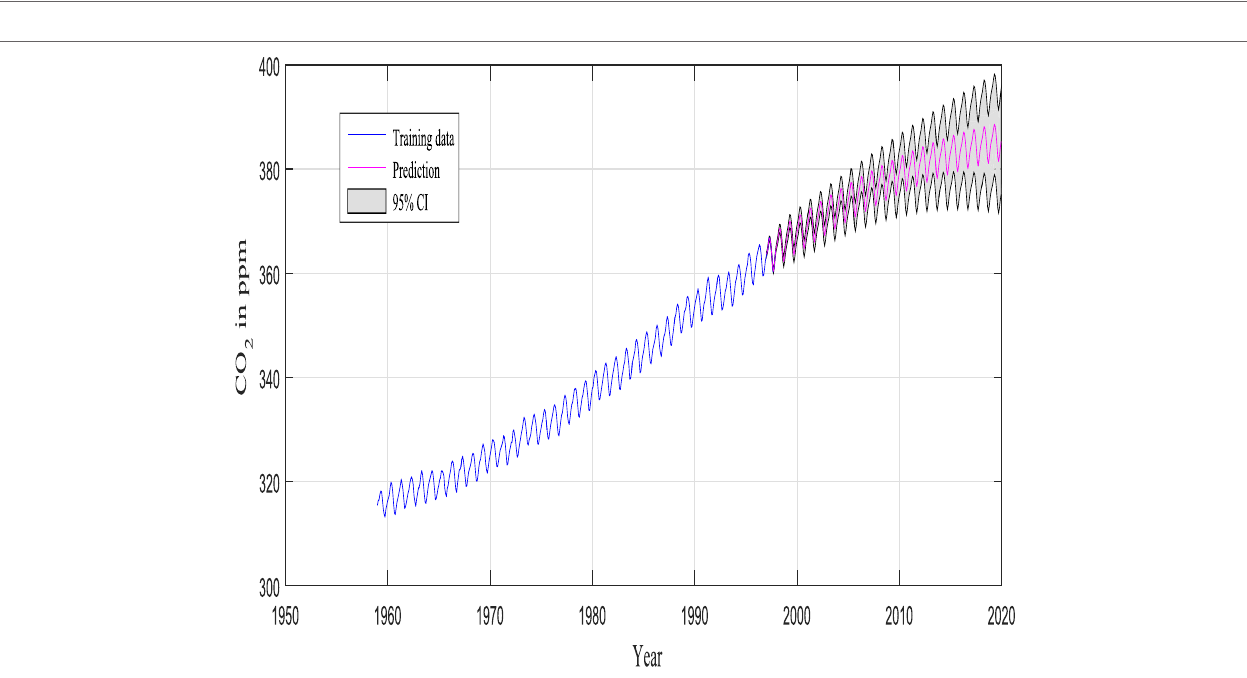
FIGURE 11 | 95% CI obtained according to Rasmussen and